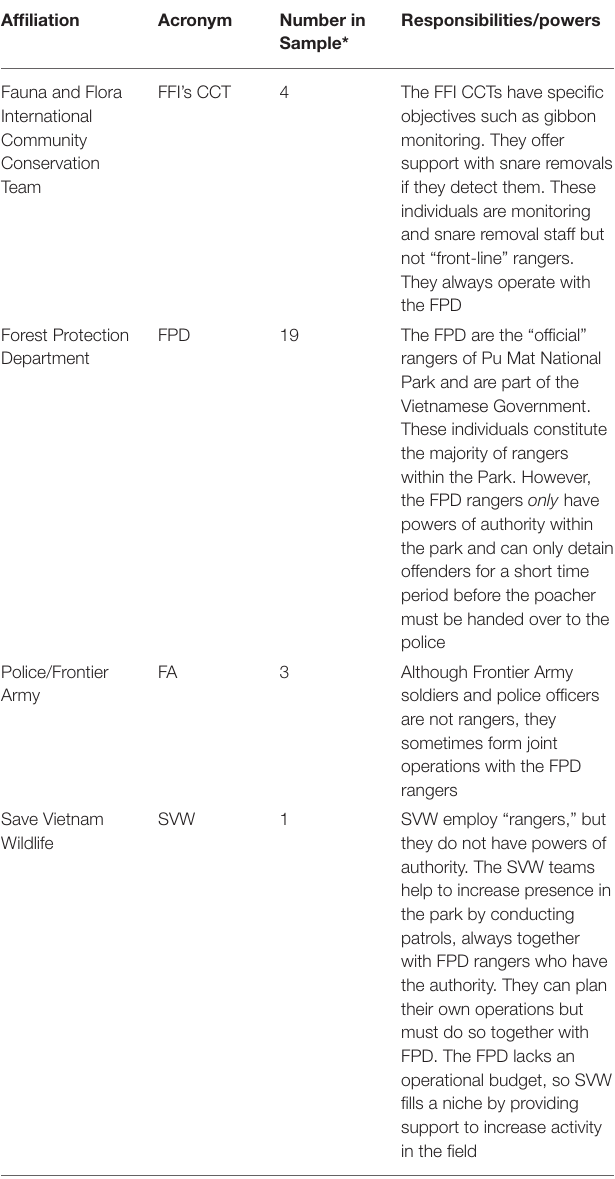
TABLE 2 | Types of Rangers/Forest Patrol in Pu Mat National